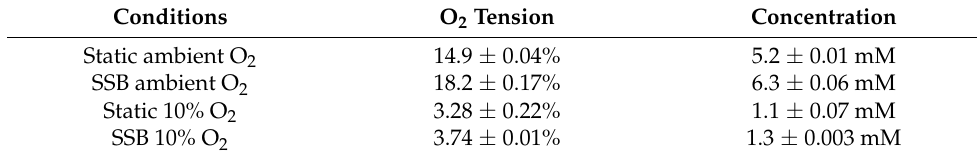
Table 2. O 2 measurements in media via spot sensors (Supplementary